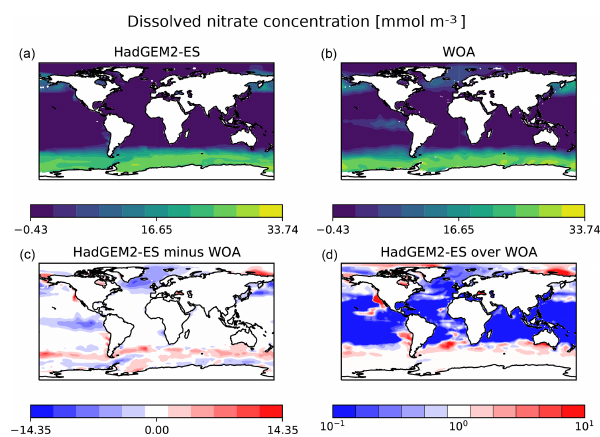
Figure 38. The surface dissolved nitrate concentration in the CMIP5 HadGEM2-ES model compared against the World Ocean Atlas 2013 nitrate. Panels (a) and (b) show the surface fields; (c) and (d) show the difference and the quotient between the two datasets. Produced with recipe_ocean_bgc.yml ; see details in Sect. 3.5.3.